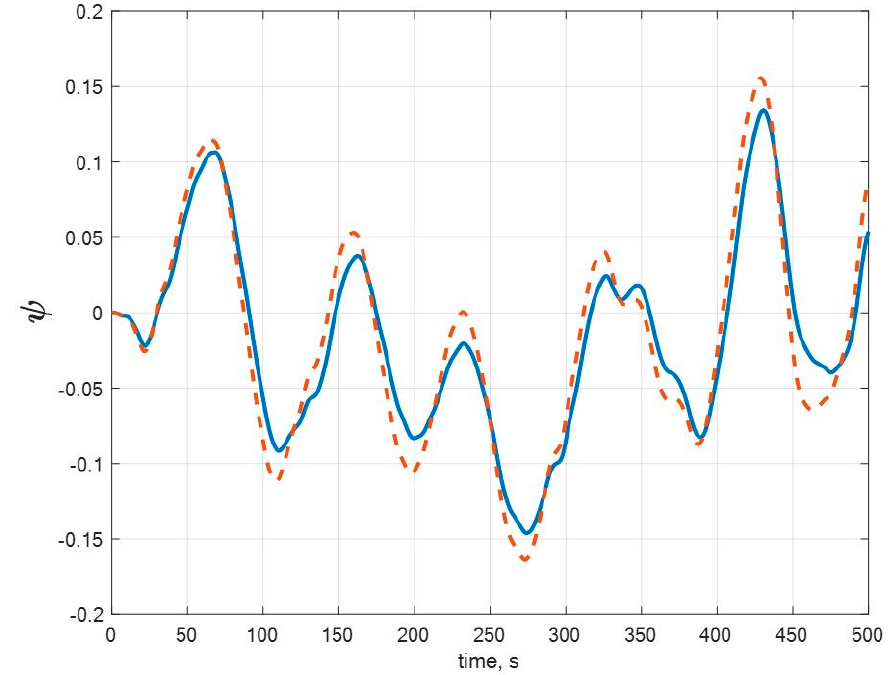
Figure 10. Transient processes of continuous and multi-rate continuous-discrete system of UAV course stabilization.